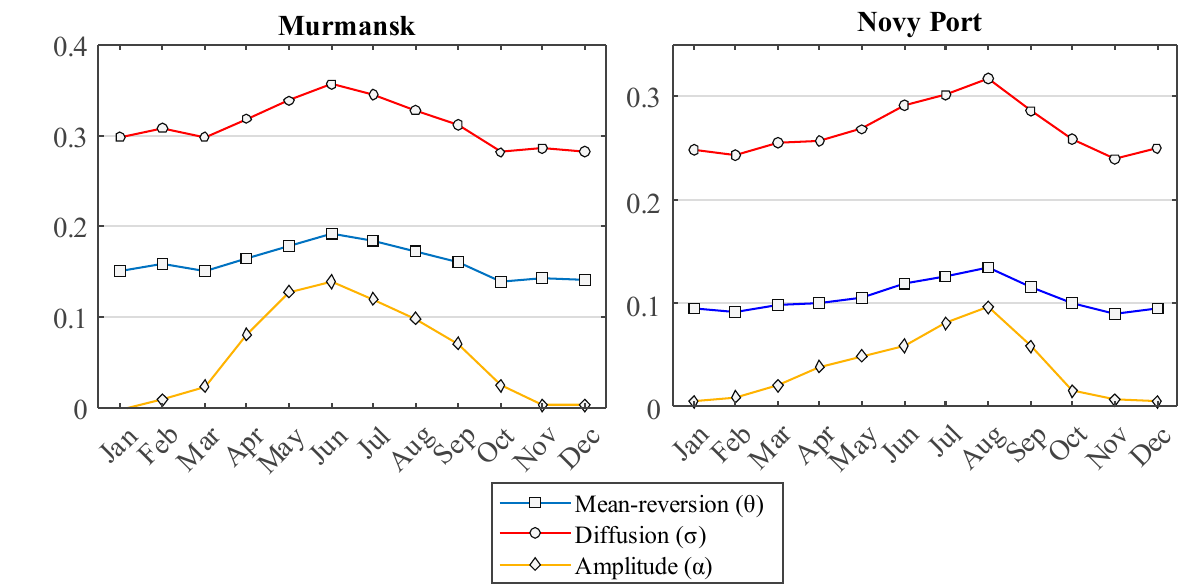
Figure 4. Estimates of SDE-model parameters for each month. The estimates of the parameters of the Weibull distribution are shown in Figure 5.